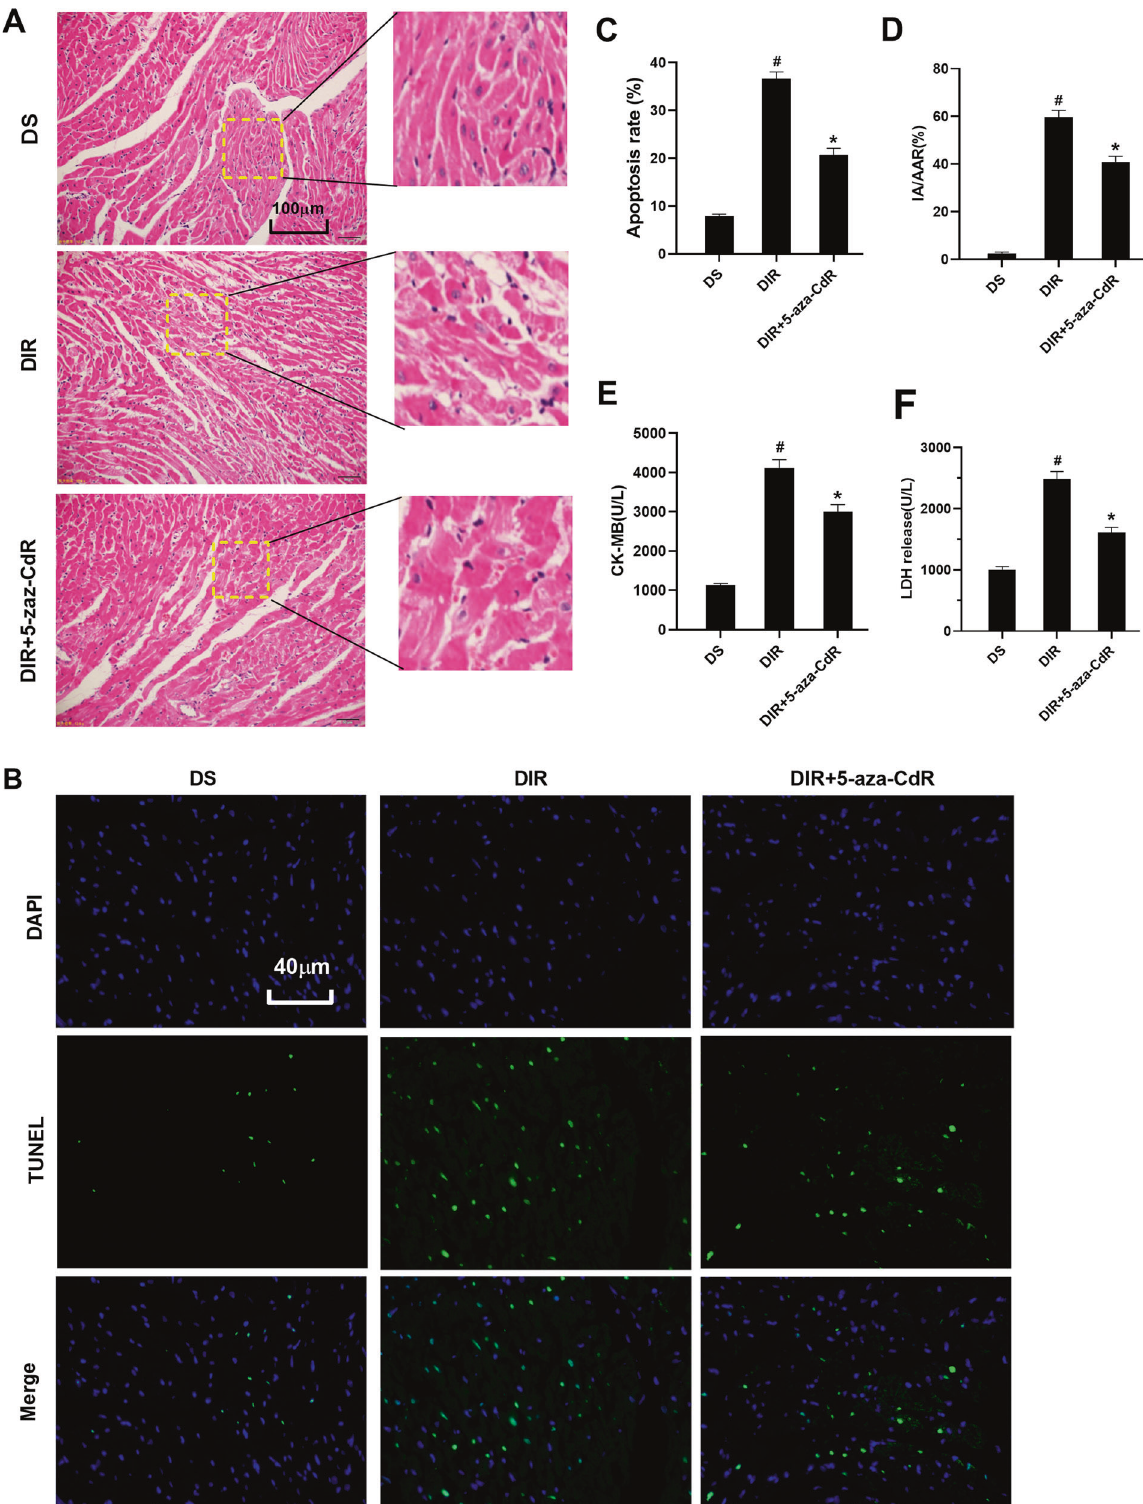
Fig. 3 Effect of DNMT-1 on pathological changes and enzyme in myocardial tissue. A Histopathological changes of myocardium were detected by HE staining. B The TUNEL staining for cell apoptosis rates were detected in different rat groups. C Cell apoptosis was shown in each group by histogram. D The myocardial infarction area was detected and expressed by AI/AAR (%). E CK-MB in serum was detected. F LDH in serum was detected. Results are presented by means ± SD. n = 8 per group. # P < 0.05 compared with the DS group. * P < 0.05 compared with the DIR